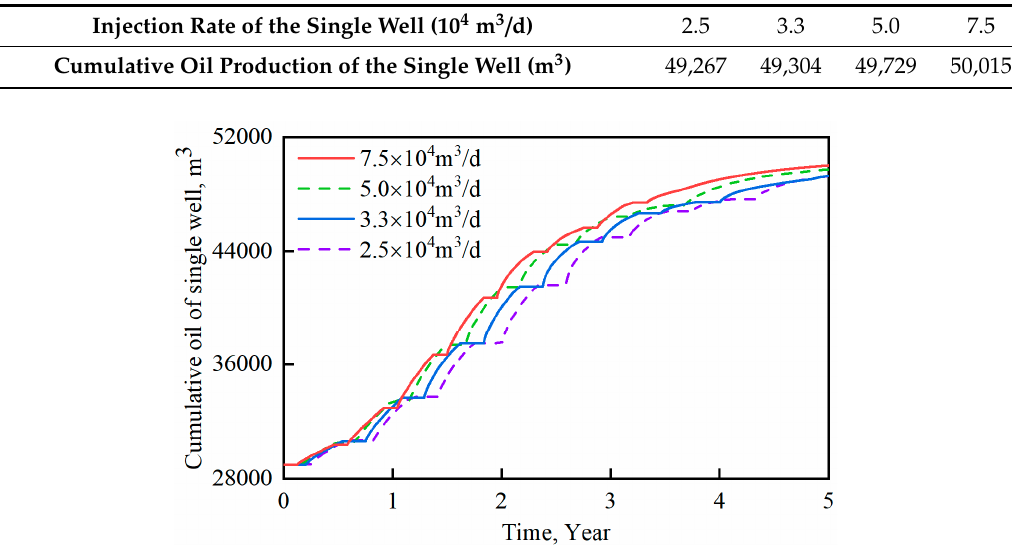
Table 7. Calculation results of different injection rates.